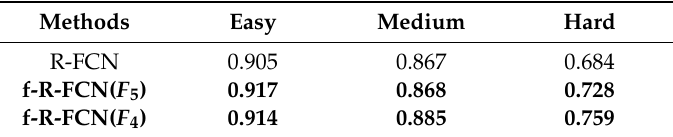
Table 3. Average precision comparison of using di ff erent fusion